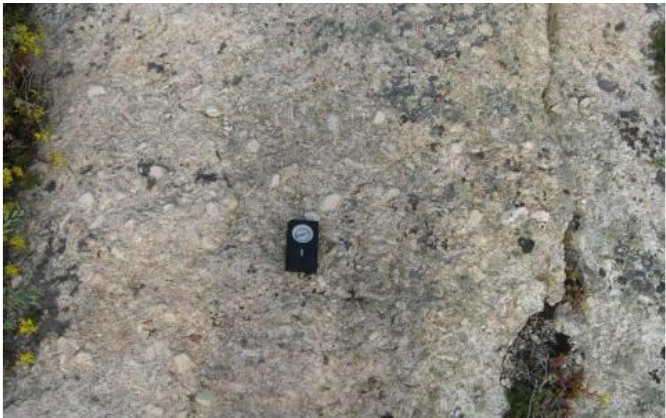
Figure 4. Porphyric granites from phase 1 of Kalba complex (sample #3 of coarse-grained and porphyritic granites).